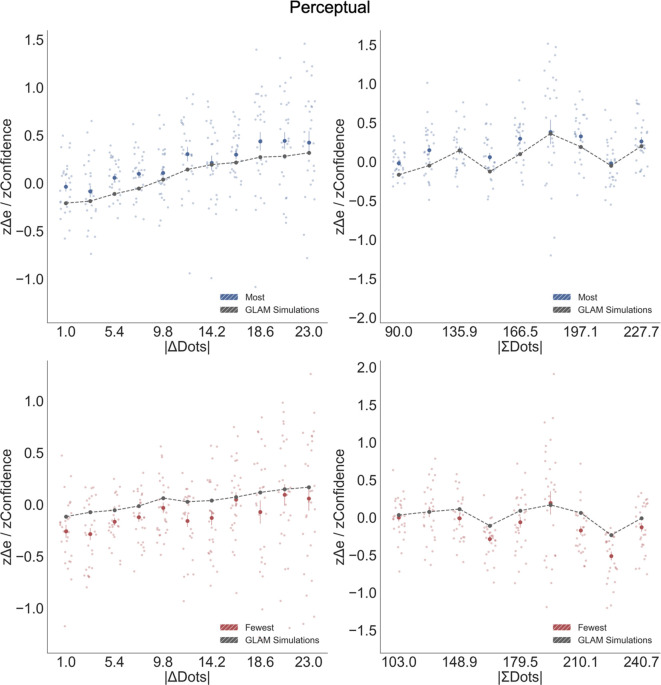
Balance of evidence simulations in the Perceptual Experiment.As in Value Experiment, the difference between accumulators (Δe) obtained from GLAM simulations matches participants’ confidence. Top left: a higher difference in number of dots between the two circles (|ΔDots|) increases confidence and simulated Δe. Top right: in the most frame, an increase in the summed number of dots (|ΣDots|) boosts confidence and simulated Δe. Bottom left: as in most frame, |ΔDots| boosted confidence and Δe in fewest frame. Bottom right: in the fewest frame, the effect of |ΣDots| over confidence flips: confidence and Δe decrease with higher number of dots in both circles, accounting for the change in goal. Blue and red dots depict the (z-scored) confidence taken from participants in most and fewest frames (respectively). Grey line presents the model simulations for both separate frames. Data were segmented in 11 bins for ΔDots or ΣDots.